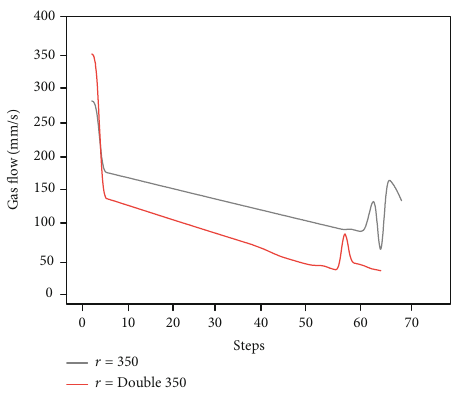
Figure 21: Flow chart for 350-mm single and double